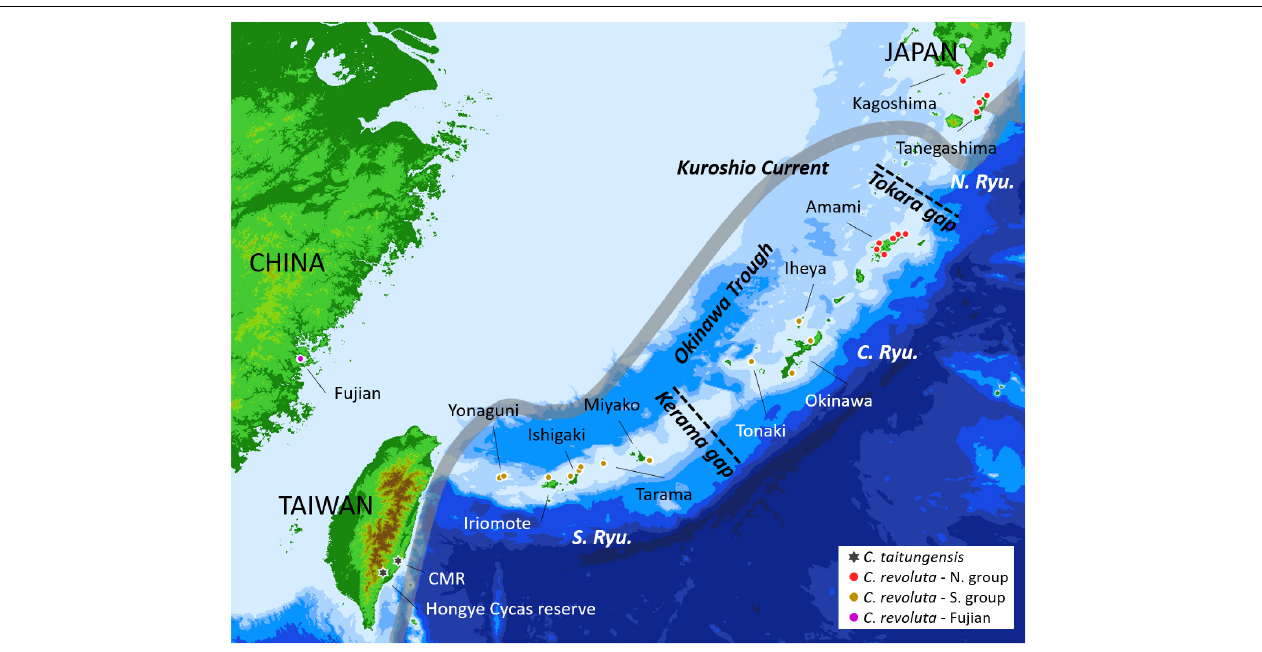
FIGURE 1 | Sampling localities of Cycas revoluta and C. taitungensis for double-digest restriction site-associated DNA sequencing. The gray route is the course of the Kuroshio Current. The red and brown colors denote northern and southern groups according to the morphogenetic structure. CMR: Coastal Mountain Range; N. Ryu, C. Ryu, and S. Ryu refer to the northern, central, and southern Ryukyus,